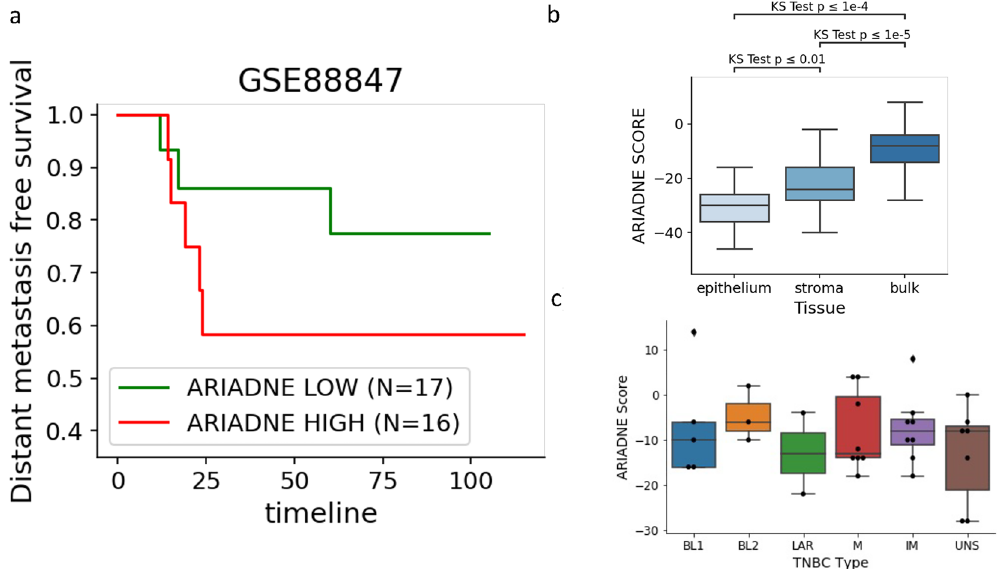
Figure 2. ARIADNE score predicts survival. ( a ) Survival curves for low (green) and high (red) patients as stratified by the ARIADNE score. The panel shows that ARIADNE is able to stratify triple-negative breast cancer patients on unseen data without the need to retrain the algorithm. ( b ) ARIADNE score for gene expression data from the epithelium and stroma adjacent tissues, compared to those from the main bulk tissue. A higher value of ARIADNE is associated to more hybrid and aggressive phenotypes. ( c ) ARIADNE scores associated with different TNBC subtypes according to 12